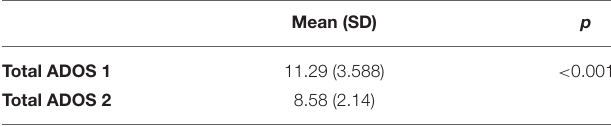
TABLE 1 | ADOS results obtained in both evaluation moments. Mean (SD) p Total ADOS 1 11.29 (3.588) < 0.001 Total ADOS 2 8.58 (2.14) Significant results at the confidence level of 95%